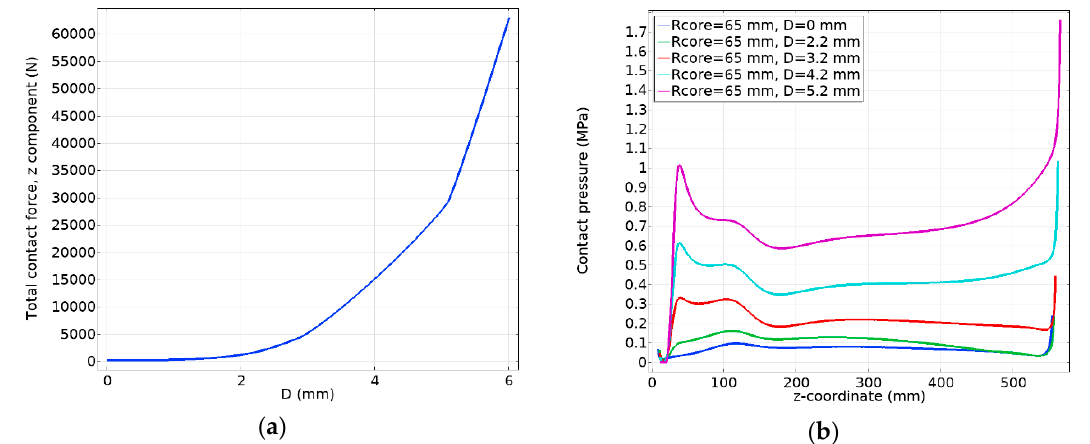
Figure 9. The figures show: ( a ) the correlation between total spring force and the supporting ring displacement; ( b ) the contact pressure distribution between the stress cone and the cable insulation against different supporting ring positions. The cable insulation radius is 65 mm.